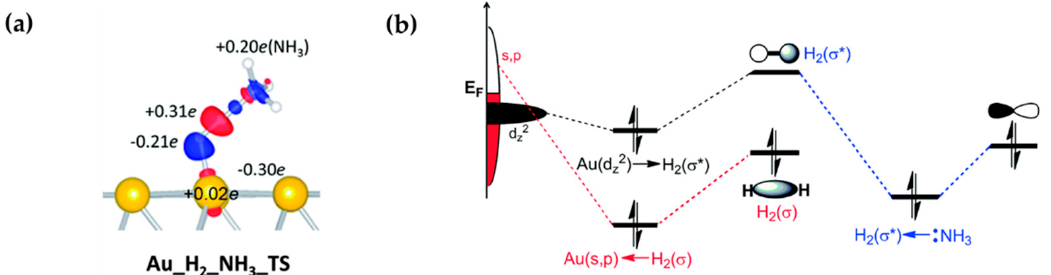
Figure 7. ( a ) Charge density difference map of the transition state of H 2 activation catalyzed by the Au/NH 3 FLP. ( b ) Schematic illustration of the favorable interactions among Au, H 2 , and NH 3 , symbol * indicated the antibonding orbital. Adapted from reference [50] with permission.